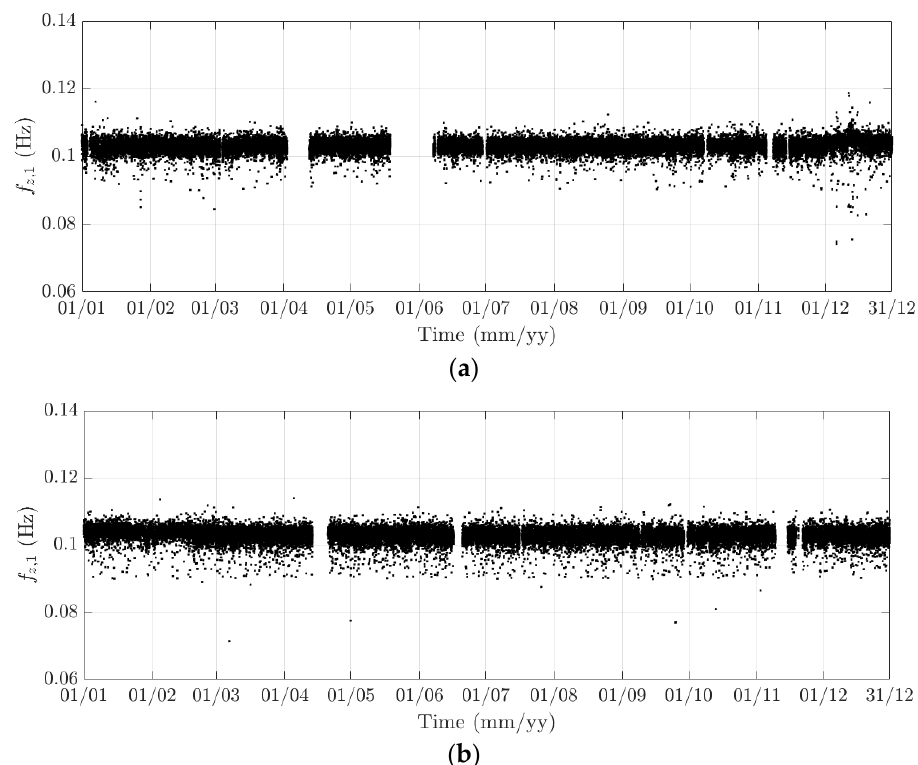
Figure 19. Variation of the 10 ‐ min natural frequency of the first heaving model in ( a ) 2015 and ( b ) 2016.